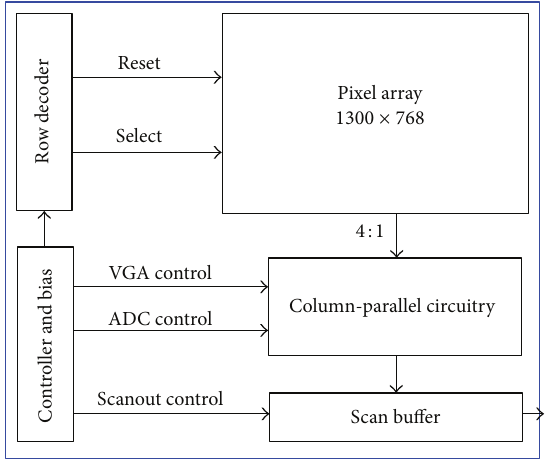
Figure 2: Proposed image sensor